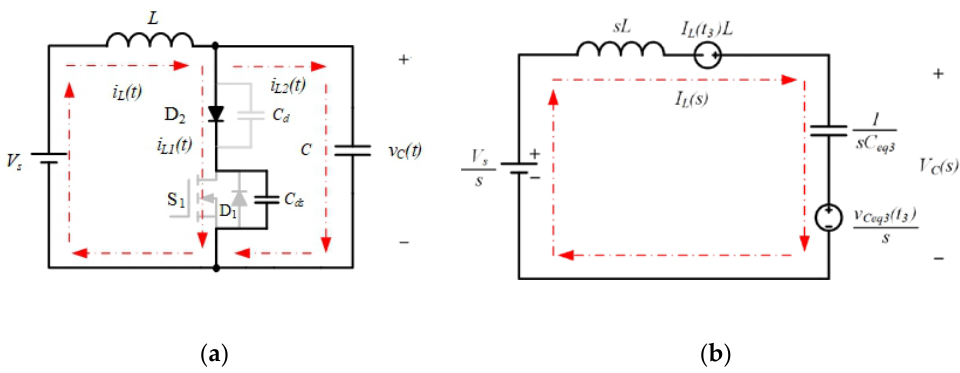
Figure 6. Mode 3 principle: ( a ) the equivalent circuit; ( b ) the Laplace transform circuit.